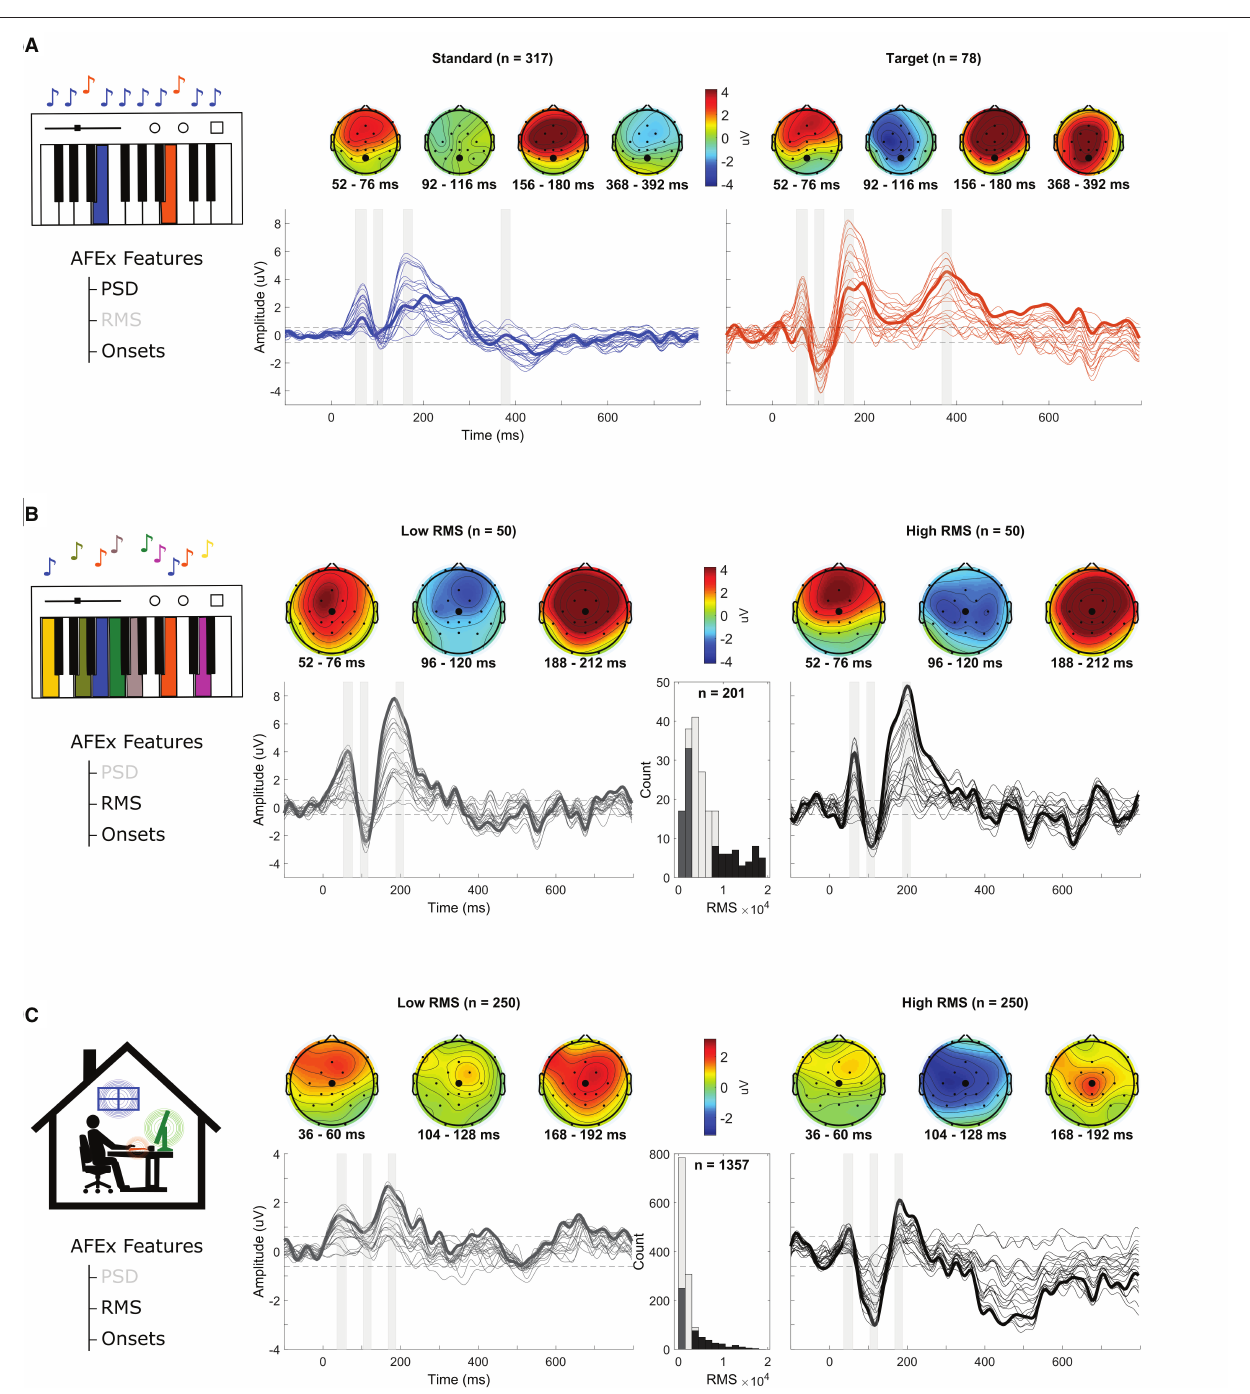
FIGURE 4 | Grand average ERPs per condition. (A) Average ERP to piano oddball, divided into standard (frequent, n orange) tones based on the PSD information. (B) Average ERP in the piano freeplay. RMS information was used to sort audio onsets from lowest to highest RMS. The ERP is shown in response to the 50 softest (left) and 50 loudest sounds (right). The histogram shows the distribution of the RMS values ( n indicates which value range was used for the plots. (C) Average ERP in response to detected sounds in the home-office soundscape (left: 250 softest sounds; right: 250 loudest sounds). The histogram shows the distribution of the RMS values ( n